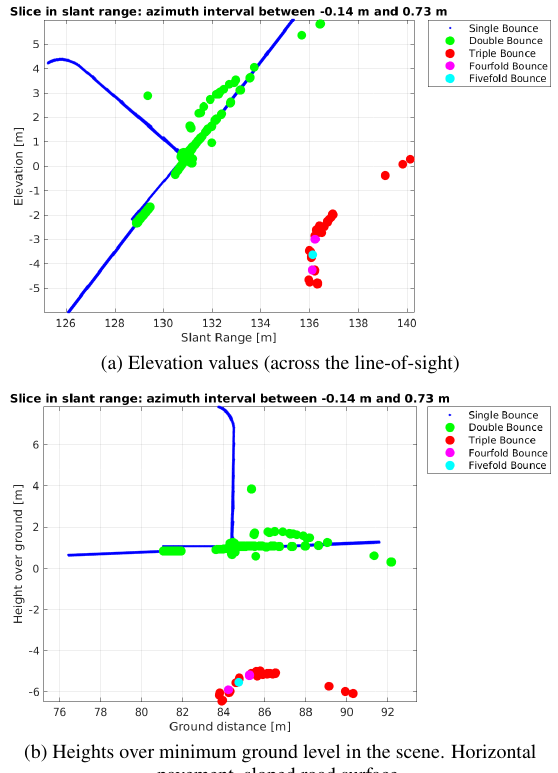
Table 1. Summary of phase center geometry and aspect dependence (values rounded to cm). Compare: position of